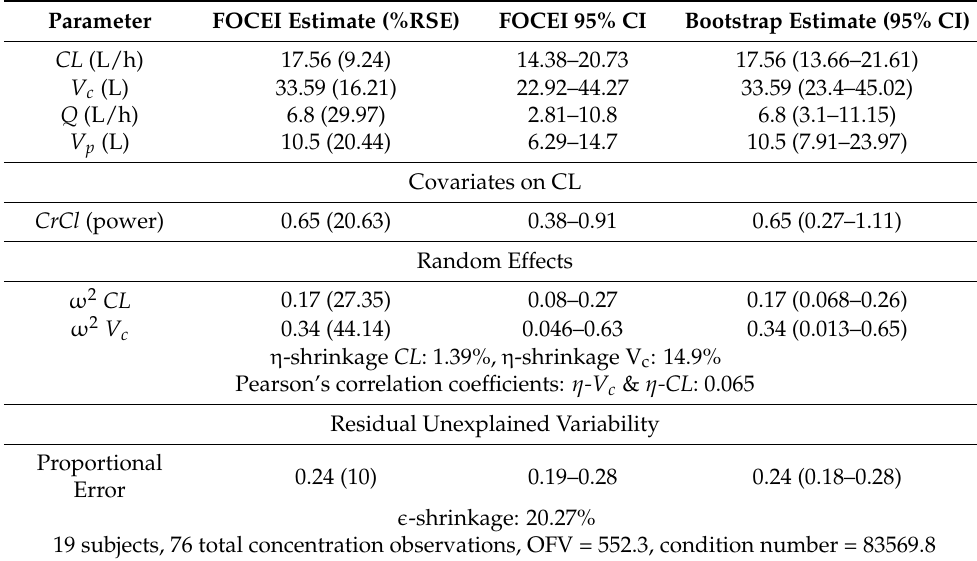
Table 2. Pharmacokinetic parameters for final piperacillin